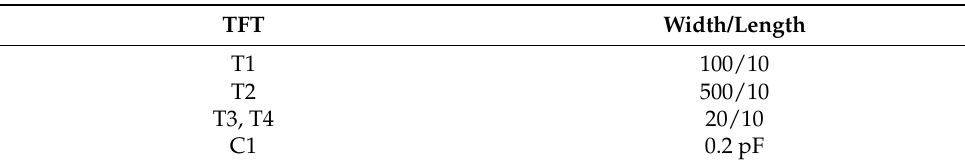
Figure 12. Microscopic image of the fabricated unit-stage drive circuits for the ( a ) bootstrap scan driver and ( b ) modified bootstrap scan driver. Table 4. Design parameters of the bootstrapped scan driver and the modified bootstrapped scan driver.